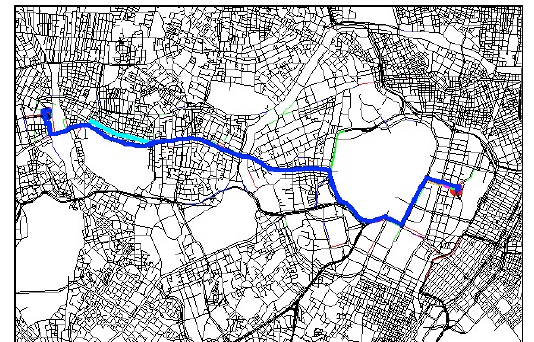
Figure 15. K-shortest routes (K = 3) in Tokyo Table 3. Cover rate and average of total length of